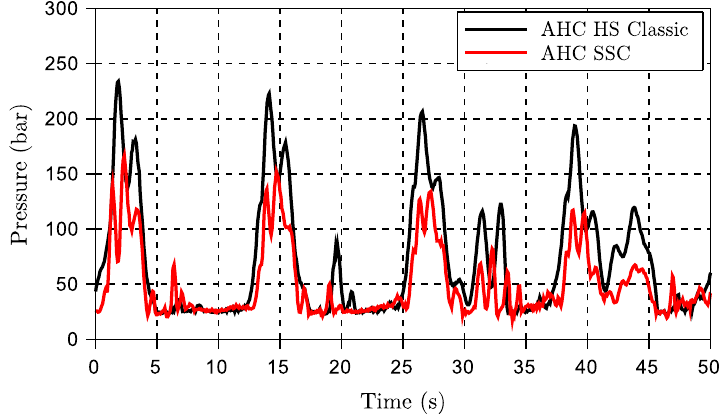
Figure 25. Pressure levels on the A-side of the active system for scenario 3.